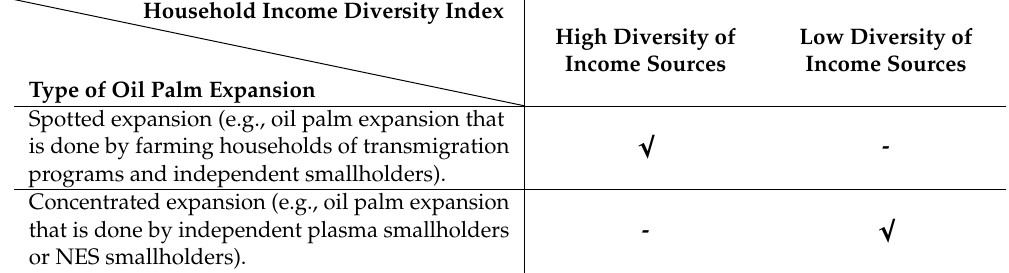
High Diversity of Low Diversity of Income Sources Income